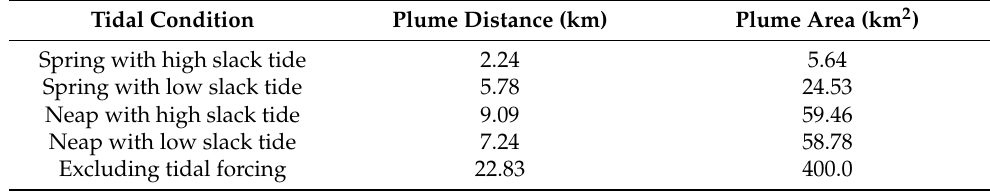
Table 7. Plume distances and plume areas under different tidal forcings and excluding tides.